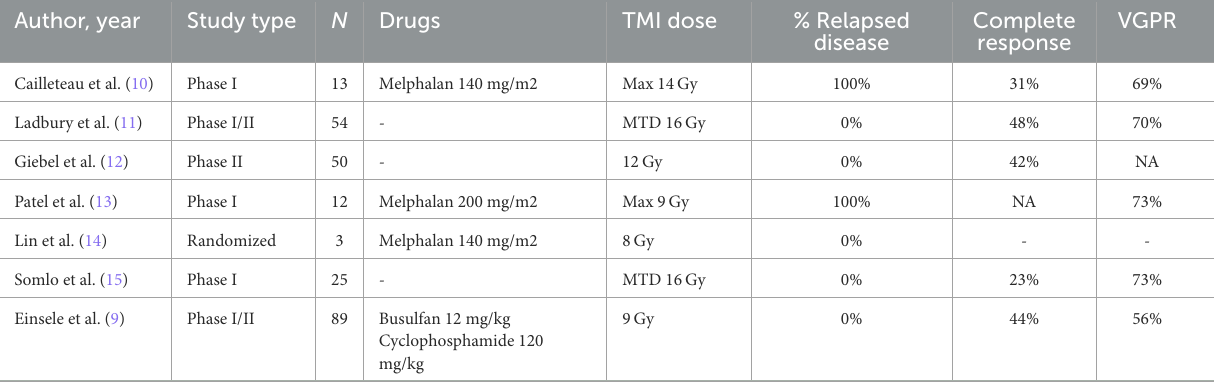
TABLE 1 Clinical results of TMI in autologous transplants for multiple